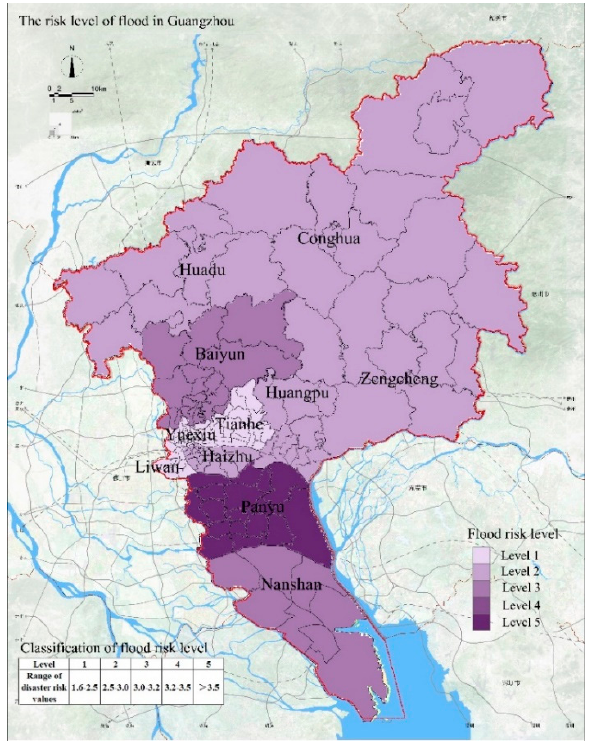
Figure 2 . The risk levels of flood in Guangzhou. Figure 2. The risk levels of flood in